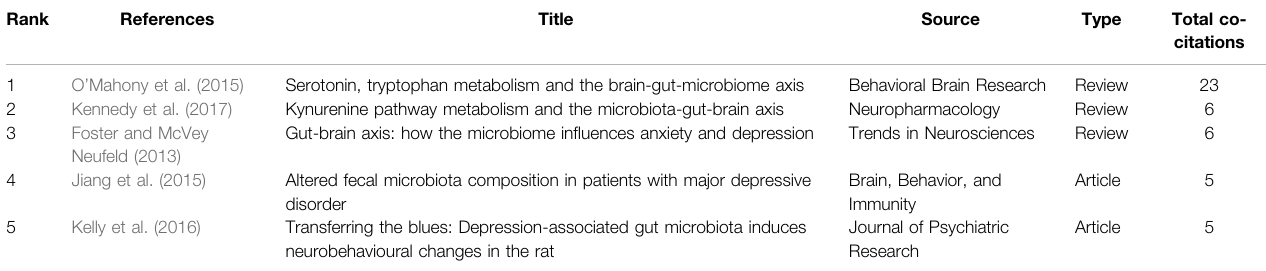
TABLE 4 | The top fi ve representative references of cluster #9, labeled “ gut-brain axis ” in the co-citation network of references.